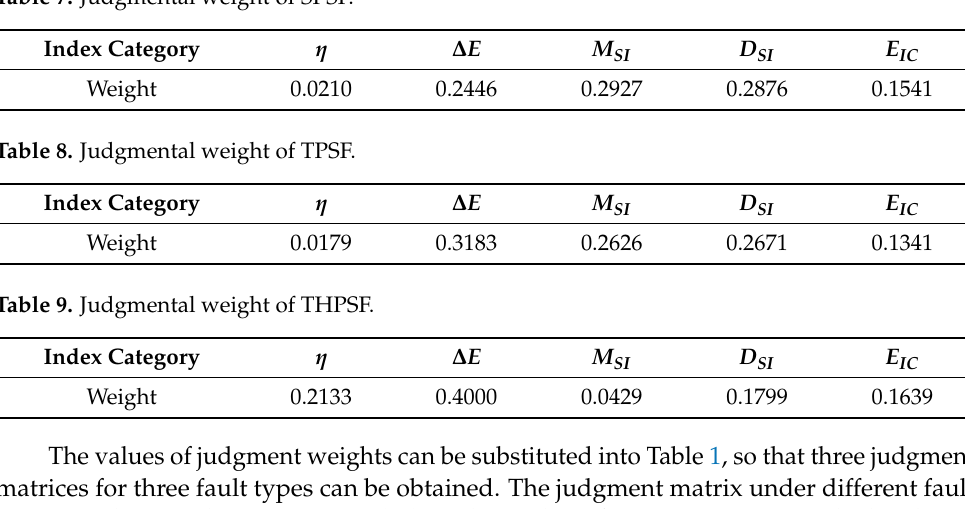
Table 7. Judgmental weight of SPSF.